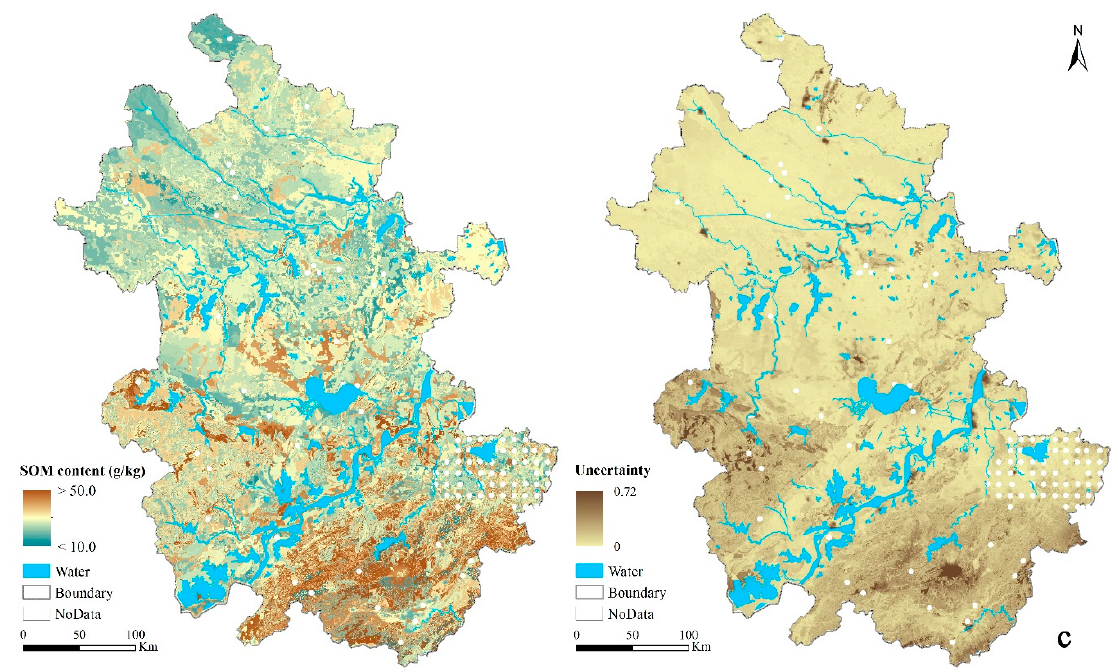
Figure 5. Maps of the top-layer SOM (g/kg) prediction and the corresponding uncertainty under the block-level test scenario T(Vr-buffer25) by ( a ) SoLIM-FilterNA, ( b ) SoLIM-FillNA, and ( c ) the original SoLIM.